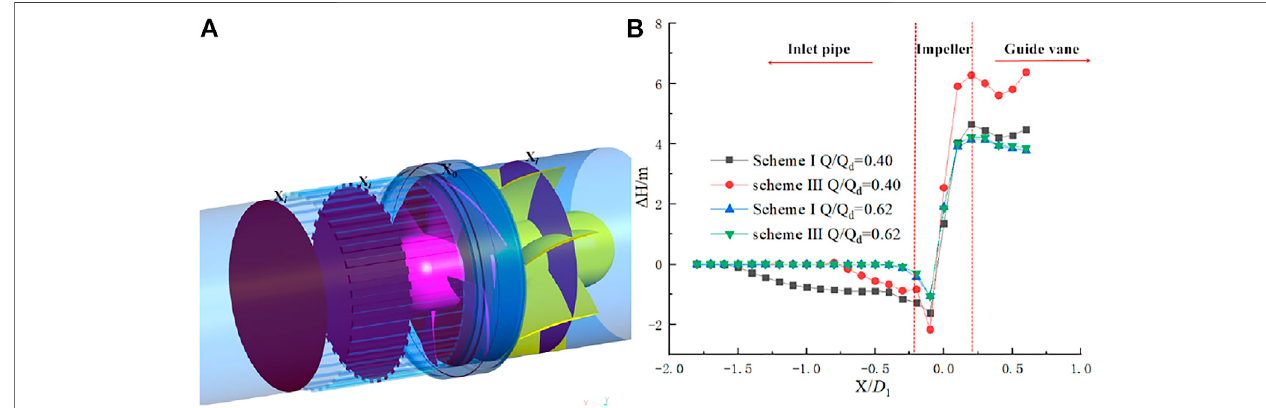
FIGURE 7 | Variation of hydraulic performance in different computational